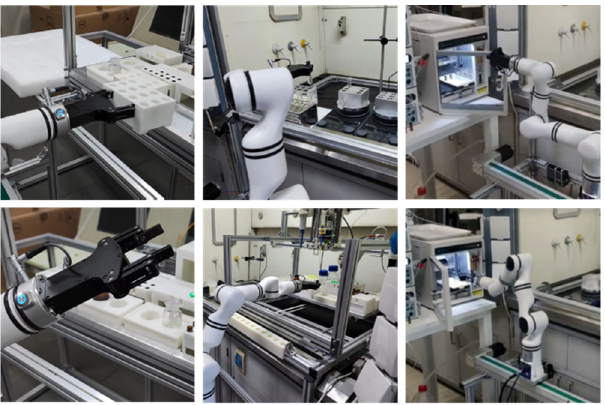
Figure 5. The robotic arm in our unmanned chemical laboratory carries out elaborate operations, such as grasping and transferring reaction tubes or sample vials and manipulating other instruments.